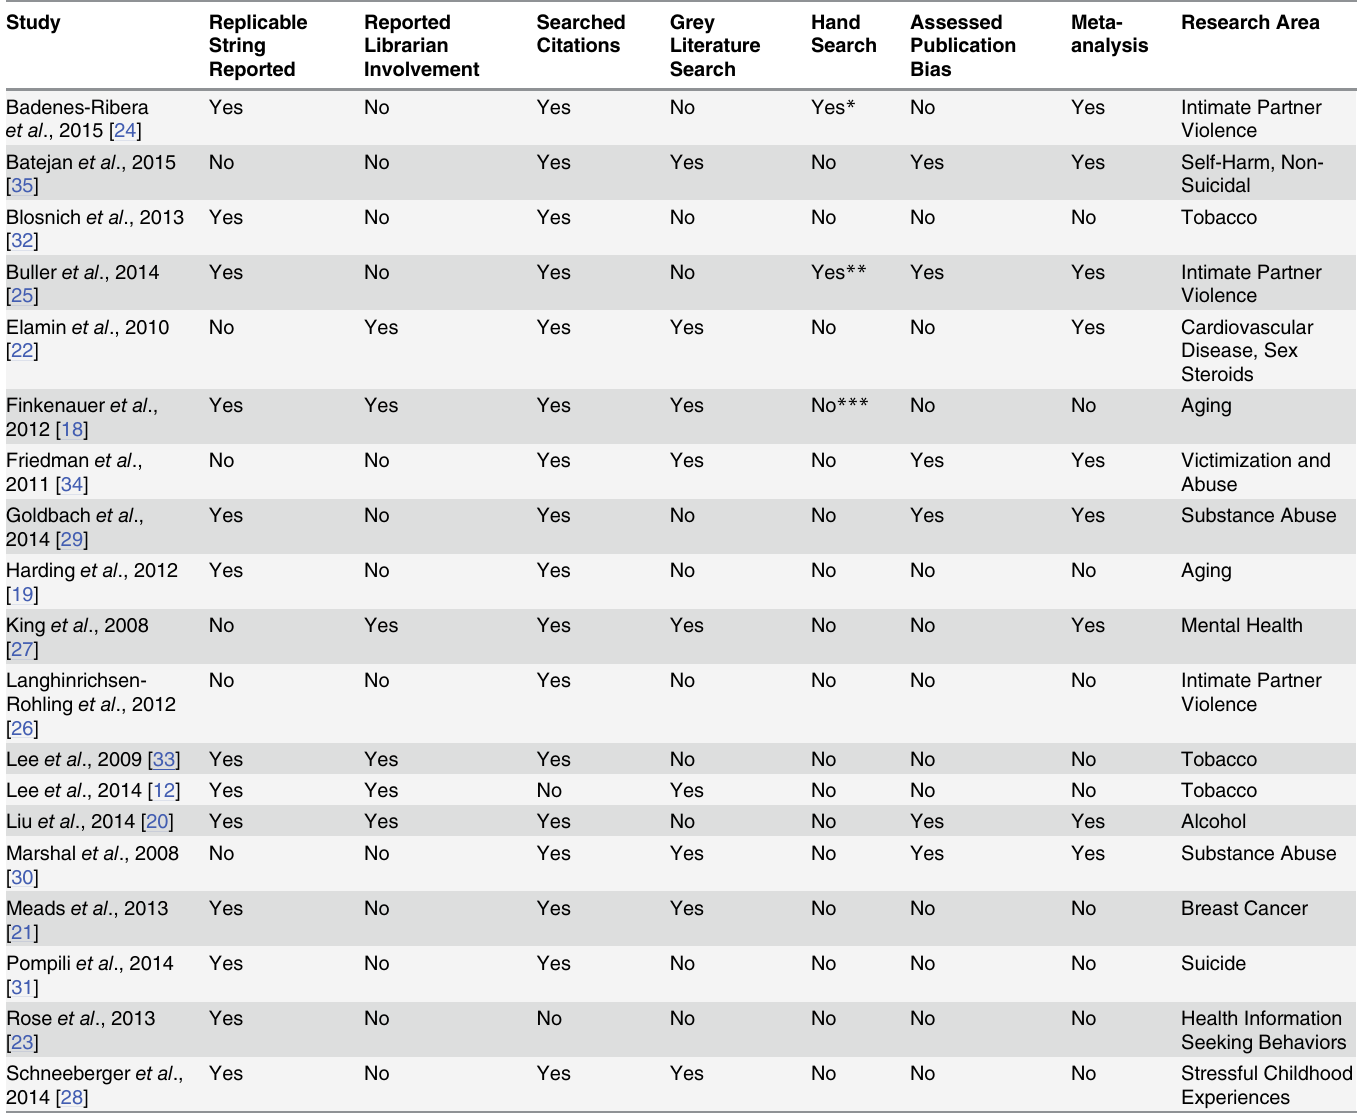
Table 2. Study Characteristics, N = 19, May 28 – 29,